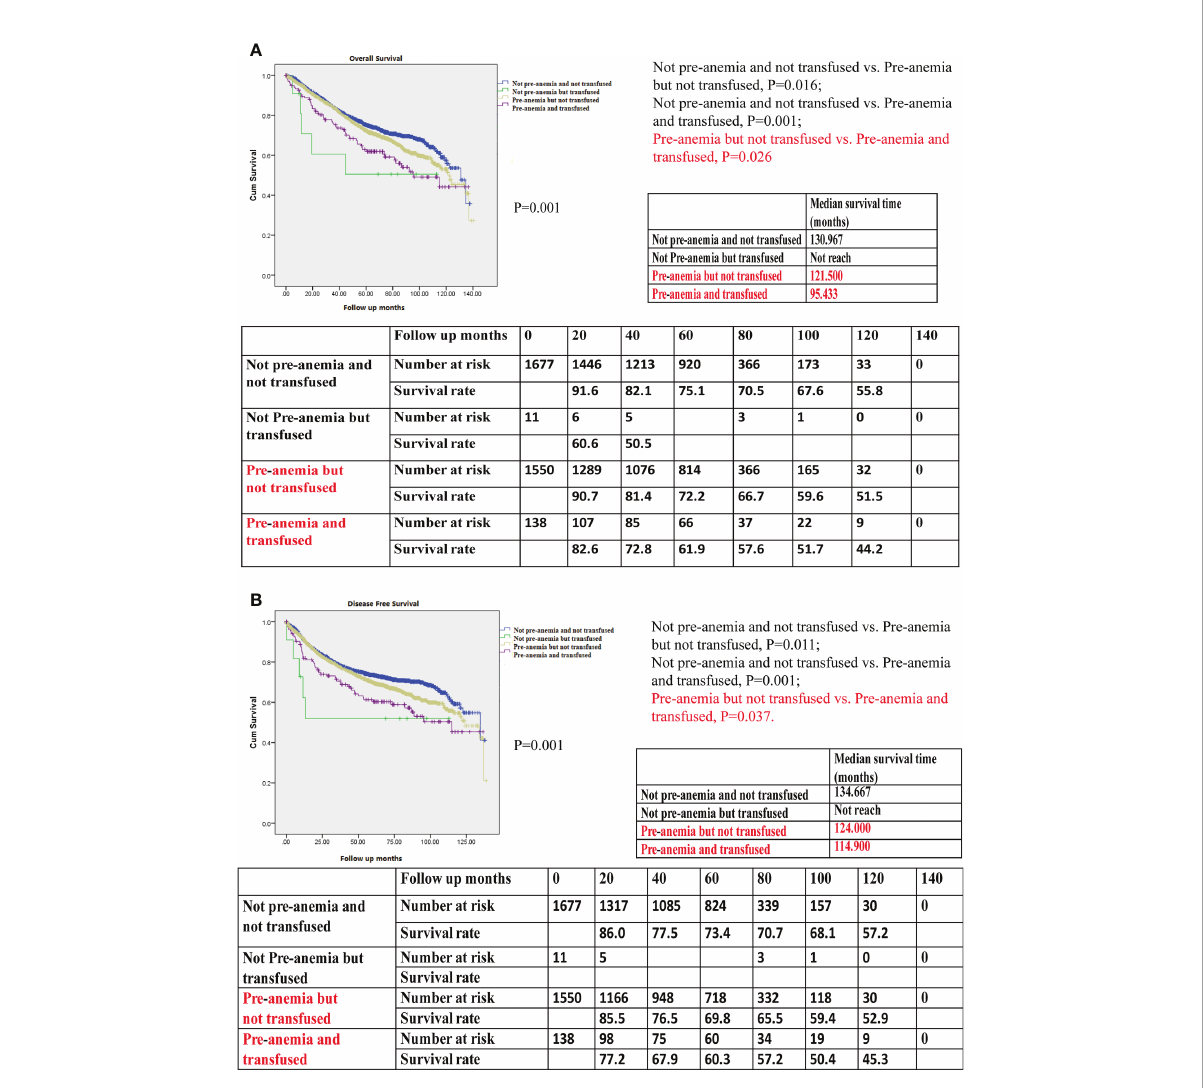
FIGURE 5 (A) Kaplan – Meier survival curve for overall survival (OS) for not preoperative anemia (pre-anemia) and not transfused, not pre-anemia but transfused, pre-anemia but not transfused, and pre-anemia and transfused in the propensity score-matched cohort. The OS rates, median survival time, and number at risk are shown. (B) Kaplan – Meier survival curve for disease-free survival (DFS) for not pre-anemia and not transfused, not pre-anemia but transfused, pre-anemia but not transfused, and pre-anemia and transfused in the propensity score-matched cohort. The DFS rates, median survival time, and number at risk are shown. The median survival time refers to the corresponding survival time when the survival rate is 50%. “ not reach ” means when a line is drawn vertically on the Y axis 0.5, it does not intersect with the survival curve. There is no corresponding survival time here. Signi fi cance with P <